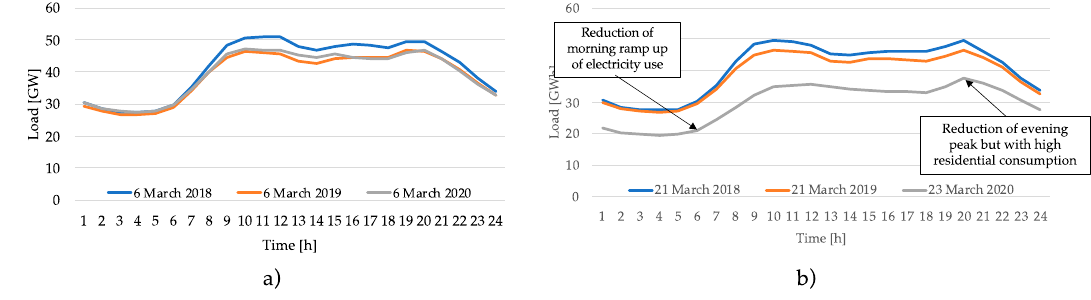
Figure 4. Italian Load profile comparison 6th March ( a ) and 20–21 March ( b ) 2018, 2019, 2020.